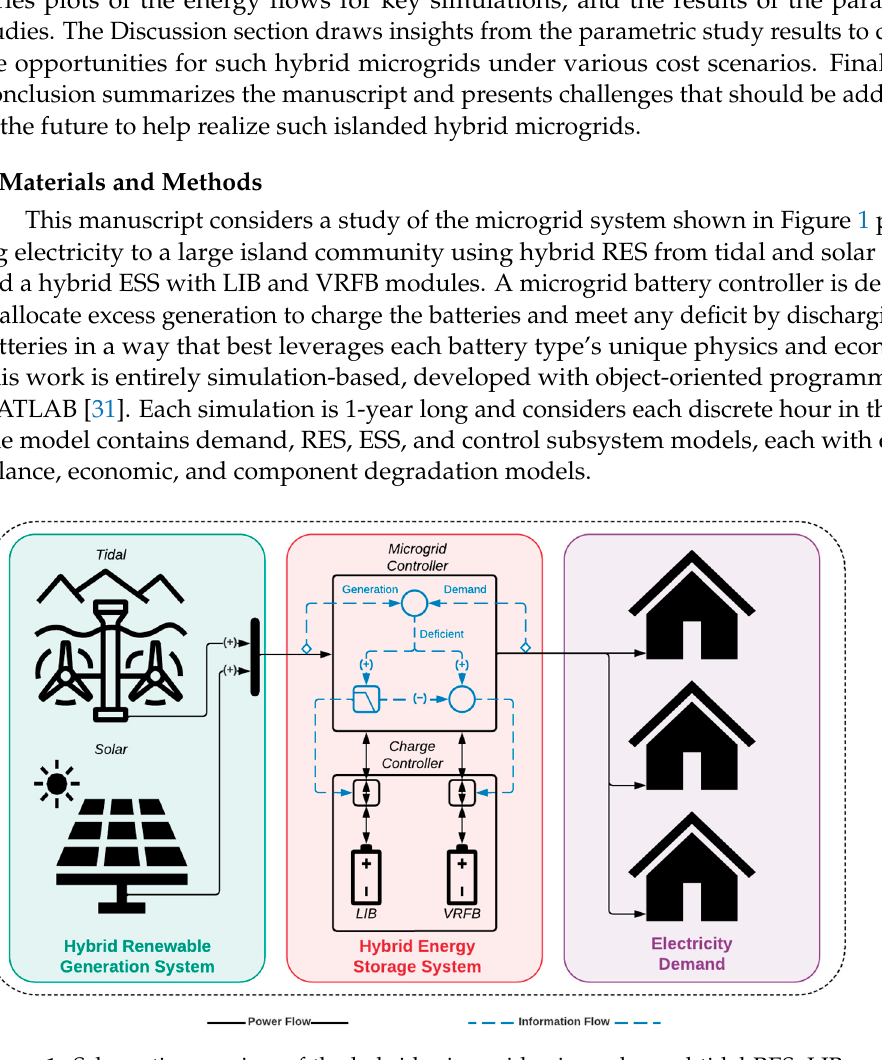
Figure 1. Schematic overview of the hybrid microgrid using solar and tidal RES; LIB and VRFB ESS; with battery (dis)charging managed by the microgrid controller to meet the island’s electricity demands. Solid black lines indicate power flow, while dashed blue lines indicate information flow.